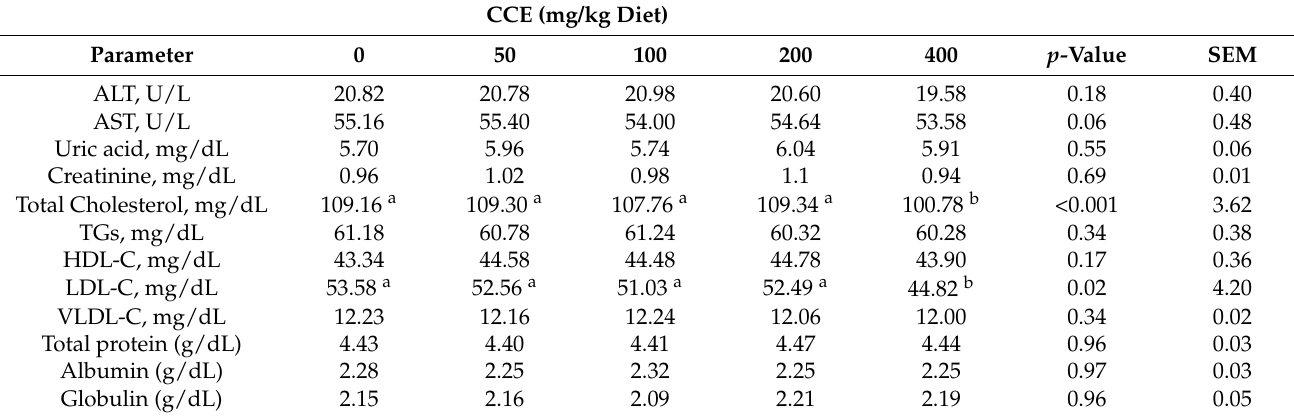
Table 4. Effect of different levels of cornelian cherry extract (CCE) on serum biochemical parameters of broiler chickens. CCE (mg/kg Diet)